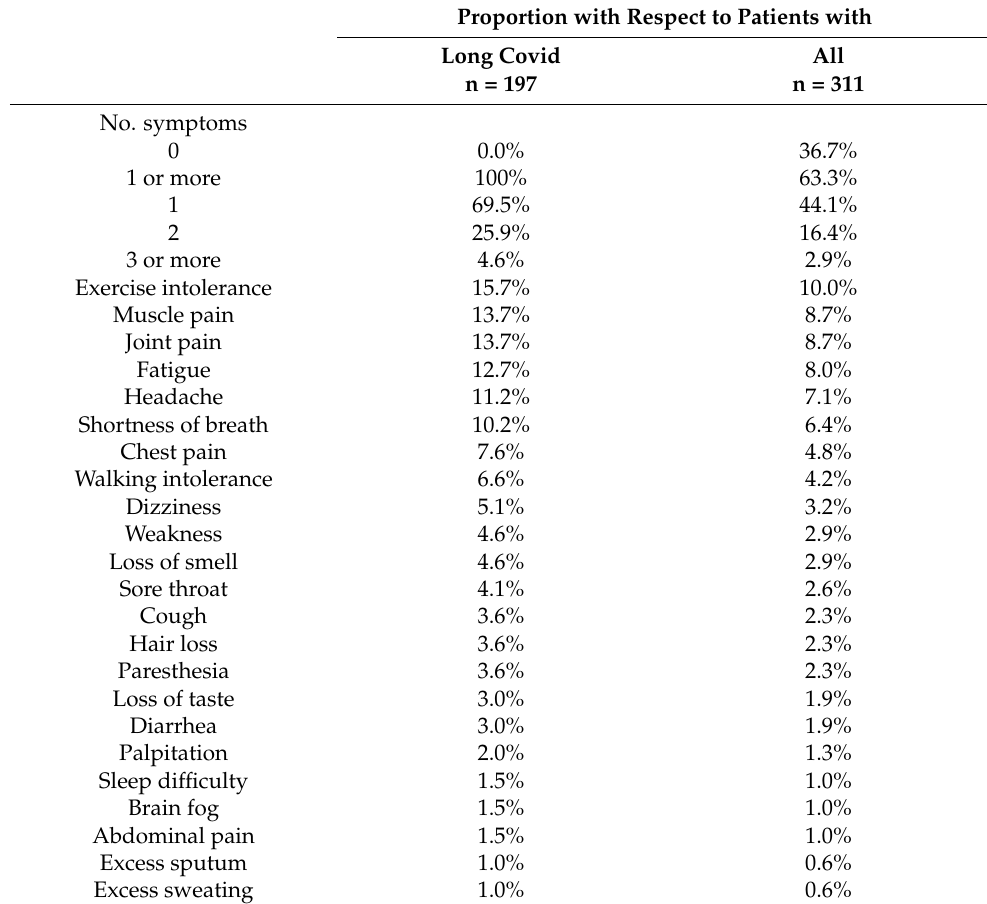
Table 1. Main symptoms/signs/complaints of long COVID of the participating subjects. Proportion with Respect to Patients